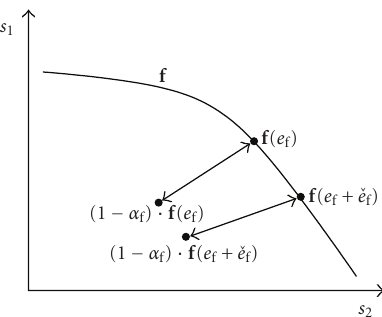
Figure 2: Illustration of how the surface-defect influence the focus measurements s 1 and s 2 for a fixed radial position (1 − α f ) · f ( e f + ˇ e f ) is the measured point parameterized with α f and ˇ e f . f ( e f ) is the point where the measurements would have been if no surface-defect were present.